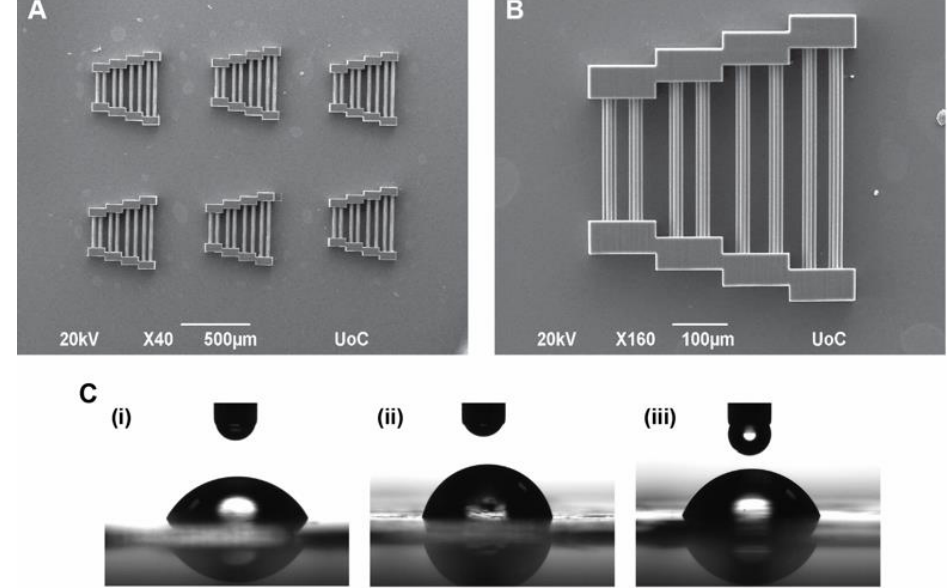
Figure 1. SEM image of fabricated scaffolds via MPL for cell cultures and contact angle measurements of thin films prepared from the same resins used for scaffold fabrication. ( A ) Typical coverslip with 6 scaffolds used for the experiments. ( B ) Magnification of a single scaffold. ( C ) Contact angle of thin films. ( i ) M aterial prepared with Michler’s ketone as a PI. ( ii , iii ) Developed ( ii ) and undevel- oped ( iii ) films prepared with SBB as a PI. Average contact angles: 62.68 ± 1.83° (i), 75.19 ± 4.43° ( ii ), 65.87 ± 1.88° ( iii ).